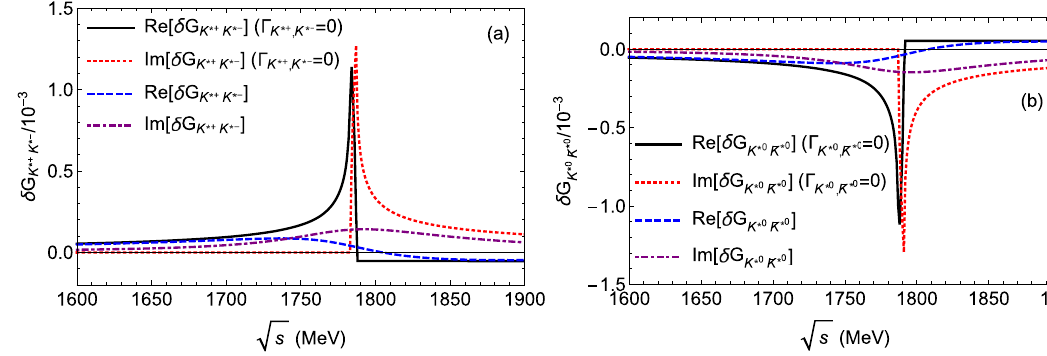
Fig. 4 Real and imaginary parts of δ G for the channels K ∗+ K ∗− ( a ) and K ∗ 0 ¯ K ∗ 0 ( b )